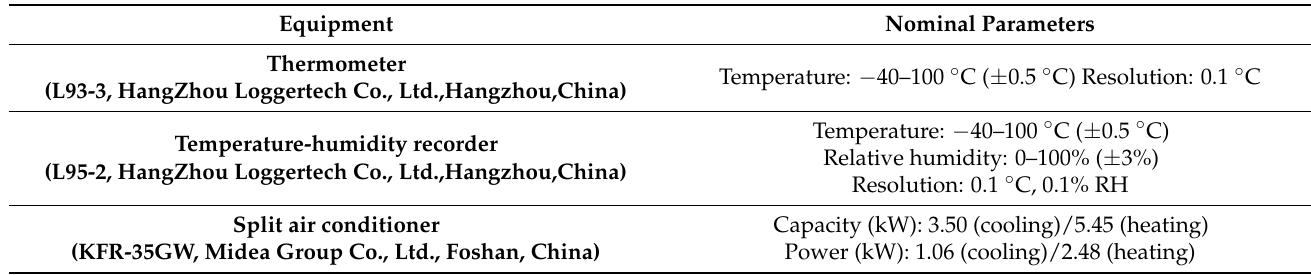
Table 1. Equipment in the tested